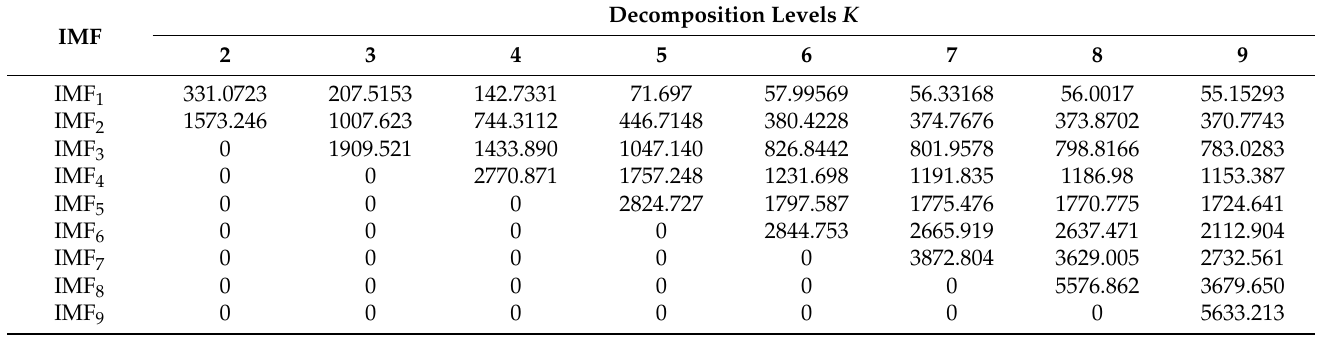
Table 3. Spectral centroid values of IMF components under different decomposition levels K .